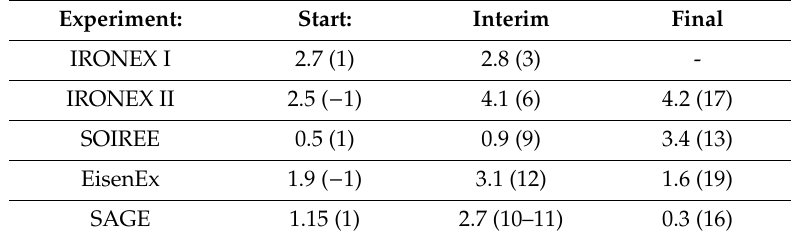
Table 4. Comparison of SAGE DMS concentrations with several other previous iron enrichment experiments. Experiment: Start: Interim Final IRONEX I 2.7 (1) IRONEX II SOIREE EisenEx Numbers in parenthesis = Lagrangian